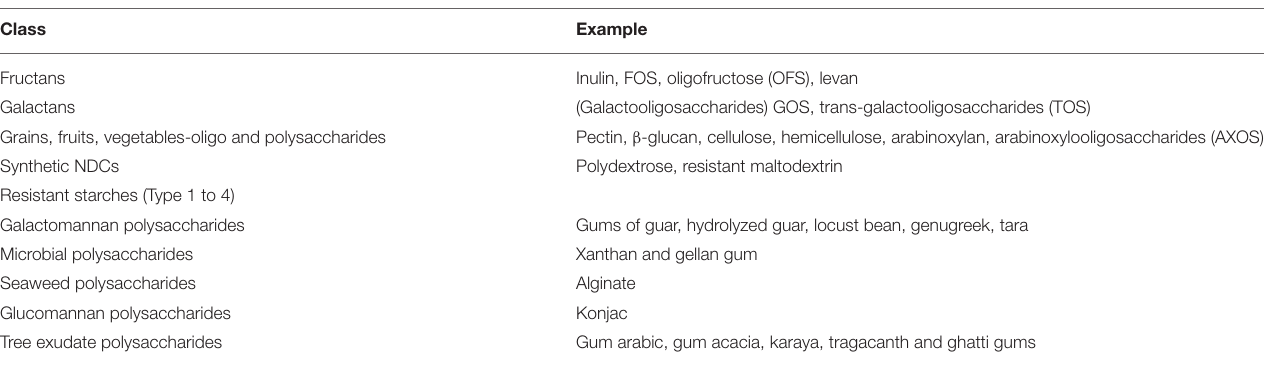
TABLE 7 | Examples of